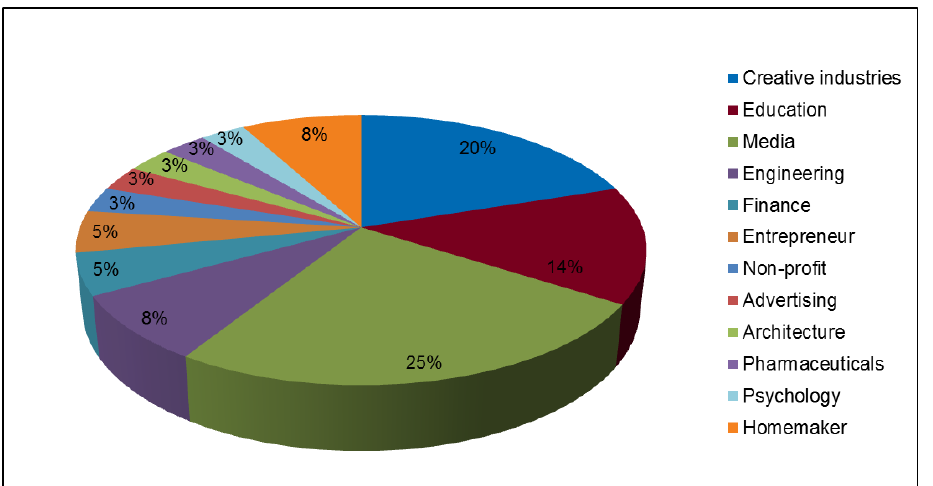
Figure 2: Professions of Chinese